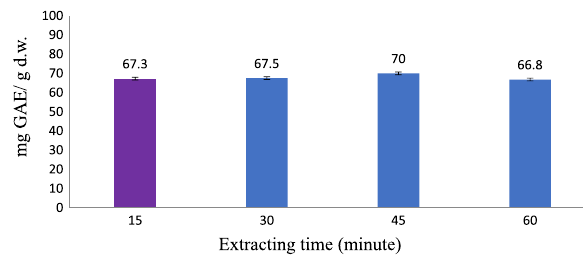
Figure 4: Polyphenol extraction a ff ected by extracting time ( Operating conditions: ethanol concentration of 70% ( v/v ) ; tem - perature: 60°C; material – solvent ratio of 1:8 g/mL; and 2 extraction cycles ) .